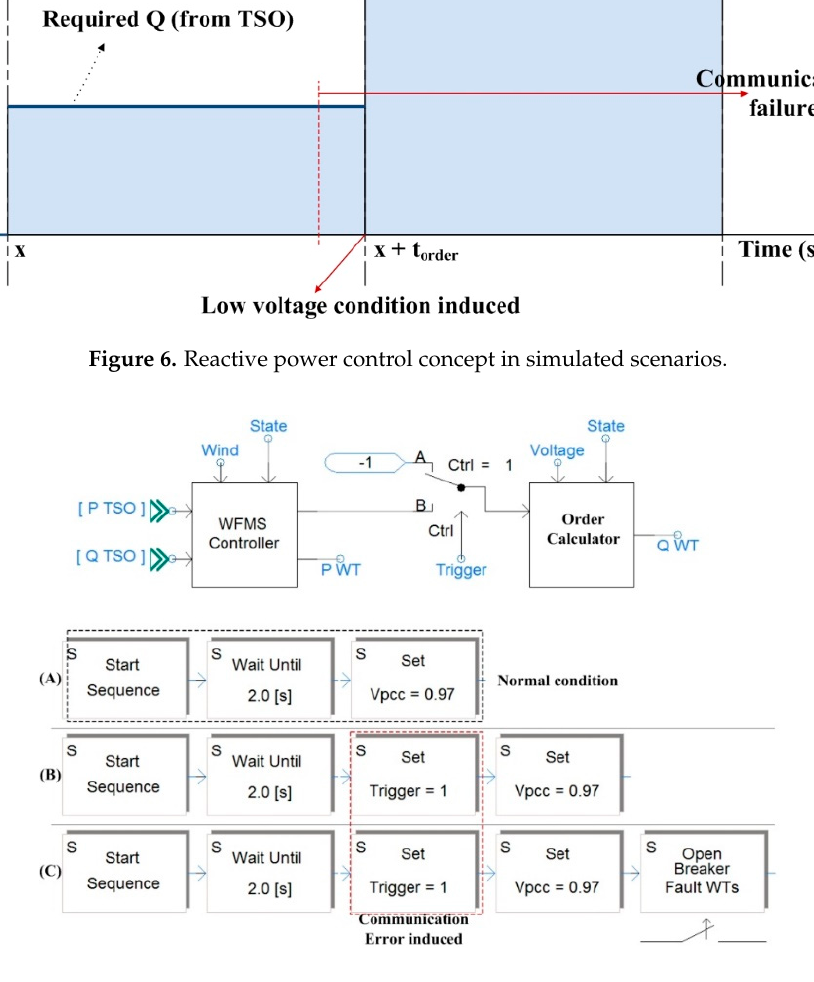
Figure 7. Modular description in the simulation program (PSCAD).